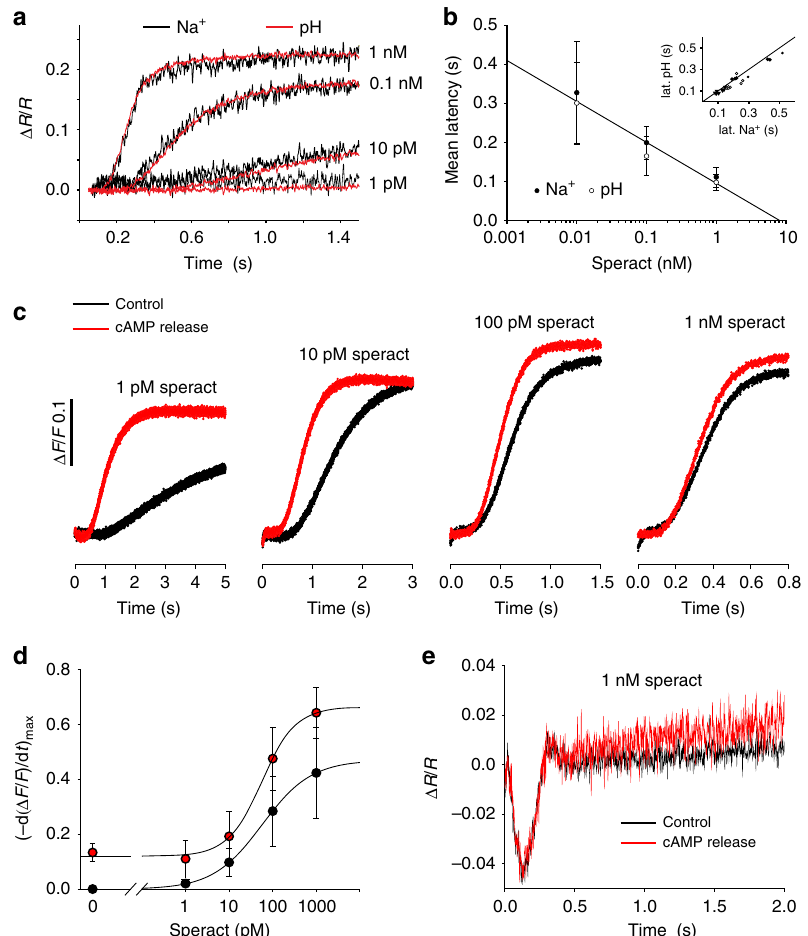
Fig. 5 Sodium and proton fl uxes in S. pupuratus sperm. a Speract-induced changes in fl uorescence ratio ( Δ R / R ) indicating Na + in fl ux (ANG2, black) or proton ef fl ux (pH i ) (BCECF, red); signals were scaled and superimposed. Speract concentrations are shown on the right. b Mean latency ± SD ( n = 7) of pH i and Na + signal plotted vs. speract concentration. Inset: latency of pH i and Na + signal at different speract concentrations (10 pM black circles; 100 pM white circles; and 1 nM triangles). The line represents the identity function ( n = 7). c Speract-induced alkalinization monitored by pHrodo Red fl uorescence in the absence (black trace) or presence (red trace) of release of cAMP from DEACM-caged cAMP with a continuously pulsing UV-LED. UV light was applied during the entire recording time. d The maximal slope of the pHrodo Red time course was plotted vs. speract concentration in the absence (black) and presence (red) of cAMP released from DEACM-caged cAMP ( n = 3). e Voltage recordings during speract stimulation (1 nM) in the absence (black) or presence (red) of cAMP released from DEACM-caged